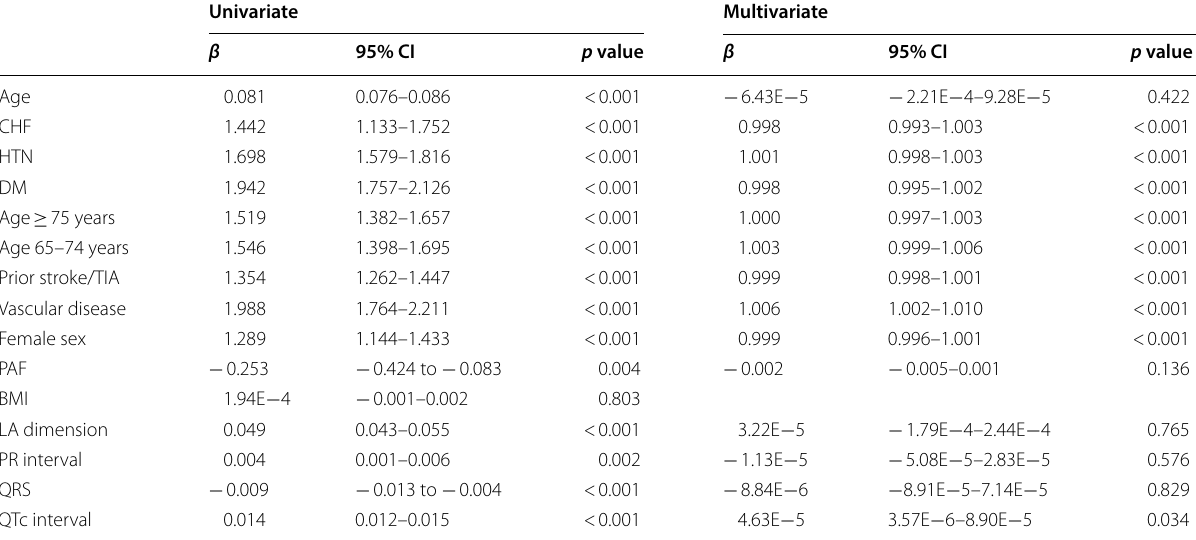
β , regression coefficient; BMI, body mass index; CHF, congestive heart failure; CI, confidence interval; DM, diabetes mellitus; HTN, hypertension; LA, left atrial; PAF, paroxysmal atrial fibrillation; TIA, transient ischemic attack